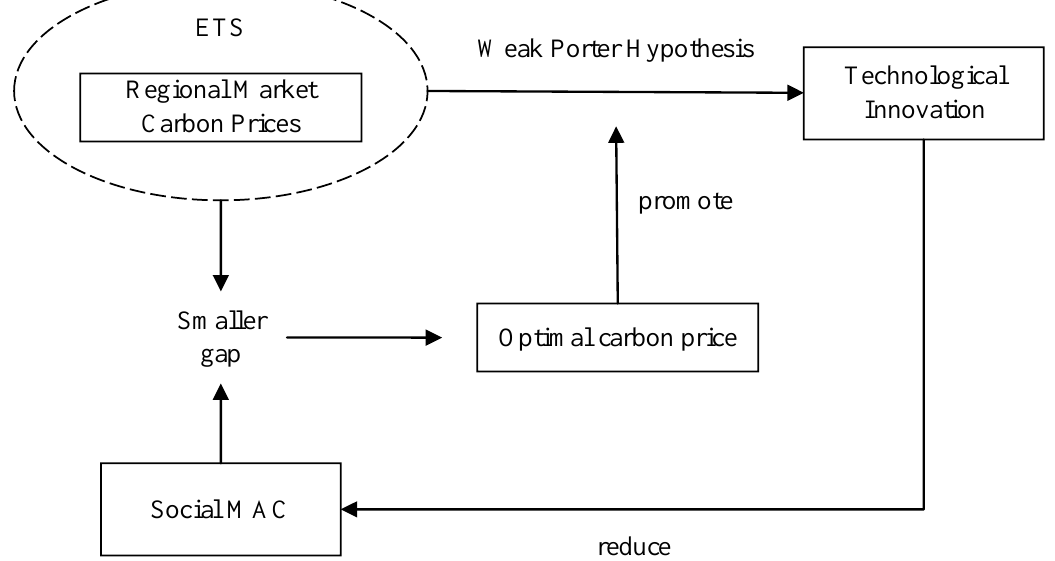
Figure 5. The overall theoretical framework diagram.